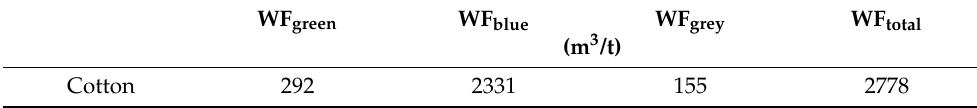
Table 3. The water footprint (WF) of cotton production in the study